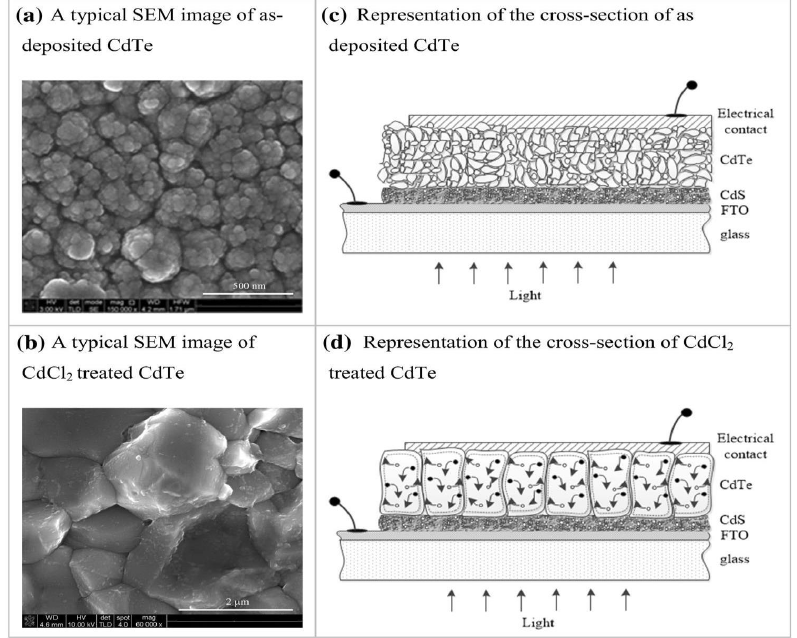
Figure 4. SEM top views of as-deposited CdTe ( a ) and CdCl 2 -treated CdTe layers ( b ). Note the presence of small crystallites 20 – 65 nm in large clusters or agglomerations. ( c , d ) The visualisation of cross-sections based on SEM and TEM observations.